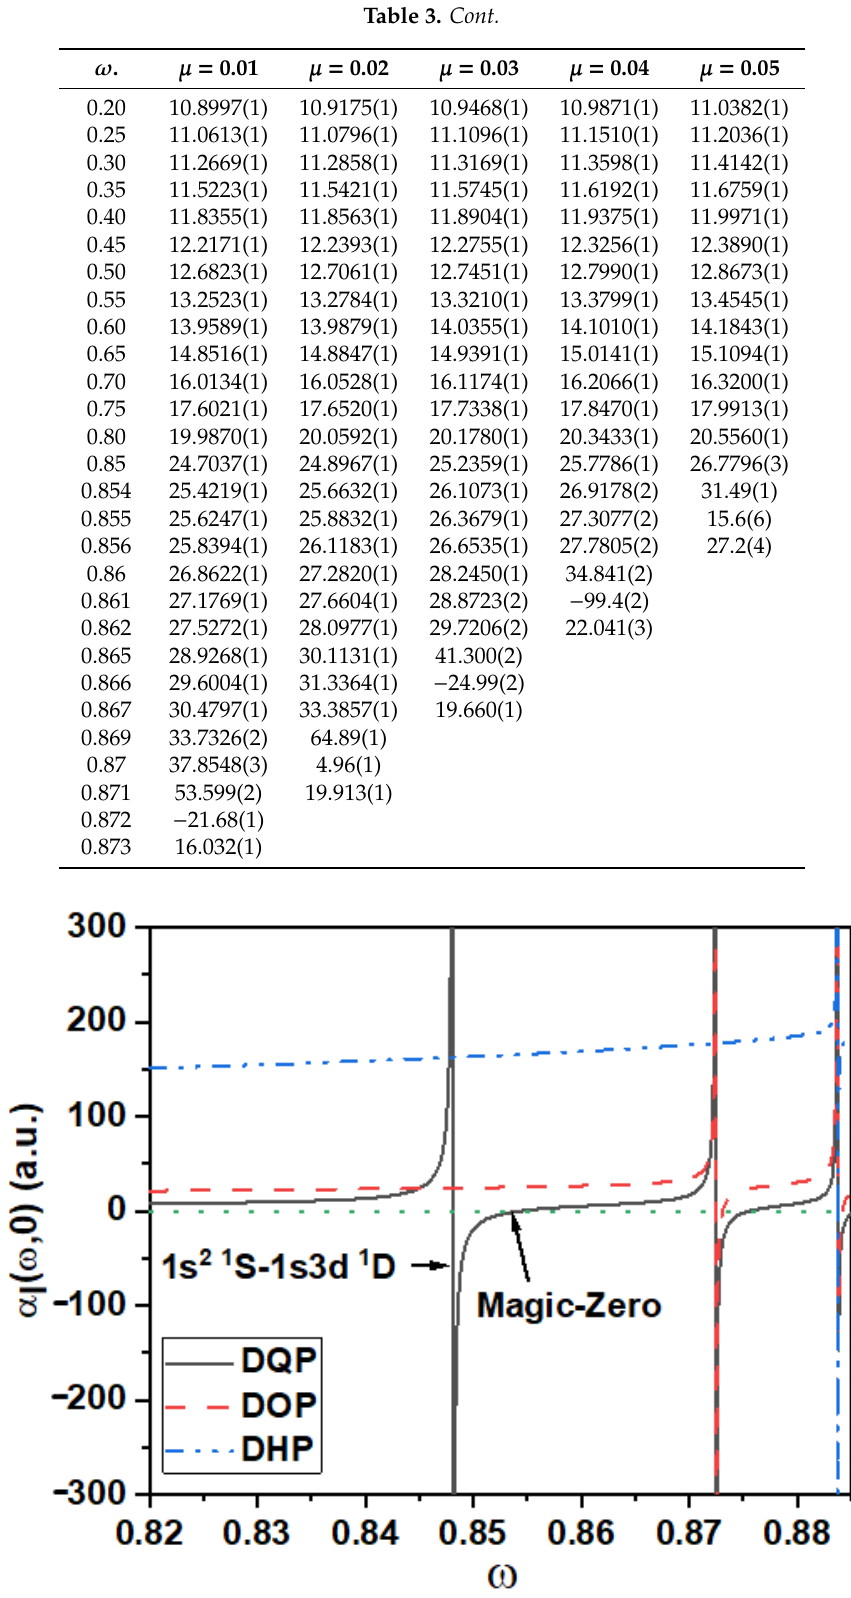
Figure 1. The dynamic multipole polarizability, α l ( ω ,0 ) (a.u.) of He for 0.82 ≤ ω ≤ 0.885. DQP, DOP and DHP denote, respectively, the dynamic quadrupole, octupole and hexadecapole